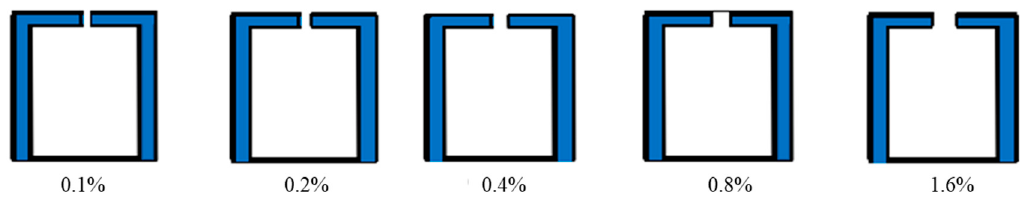
Figure 7. The variation of the orifice of the OWC in the scaled-down model structure.